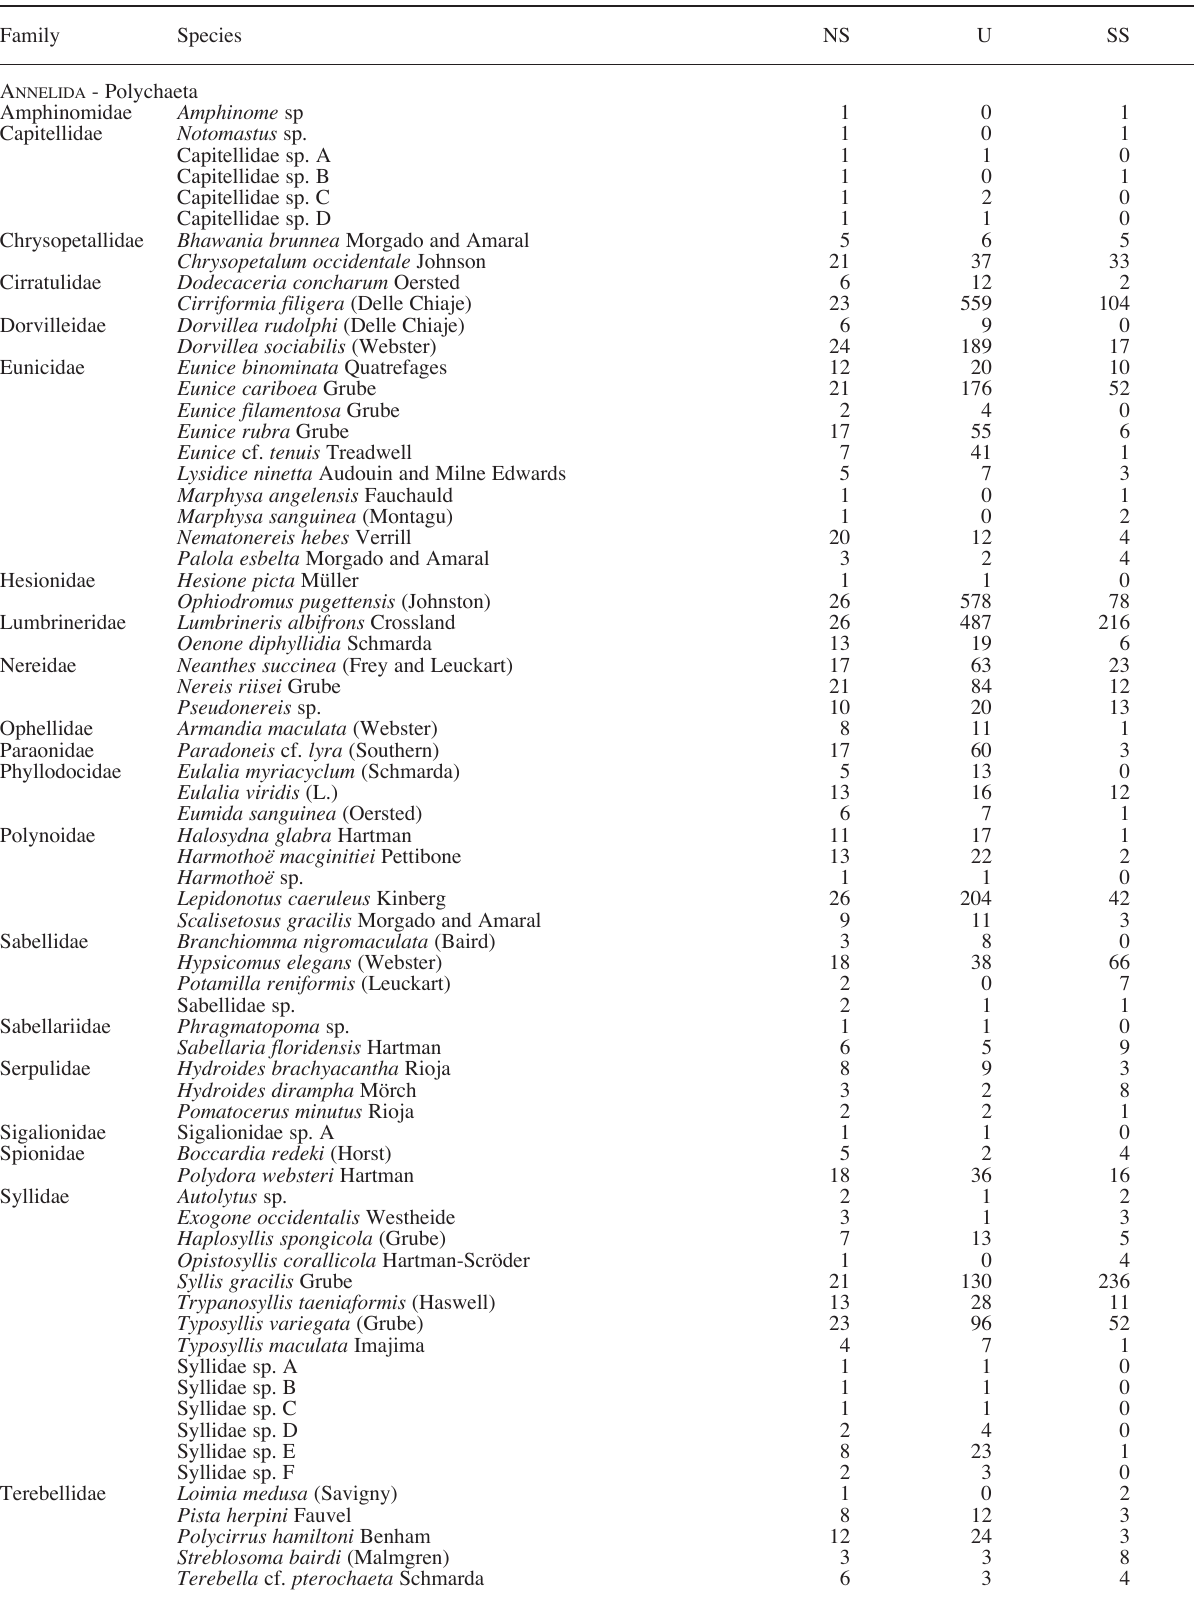
Typosyllis maculata